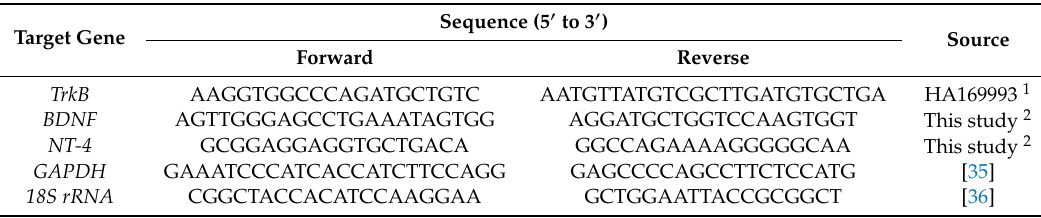
Table 3. Primer sequences for